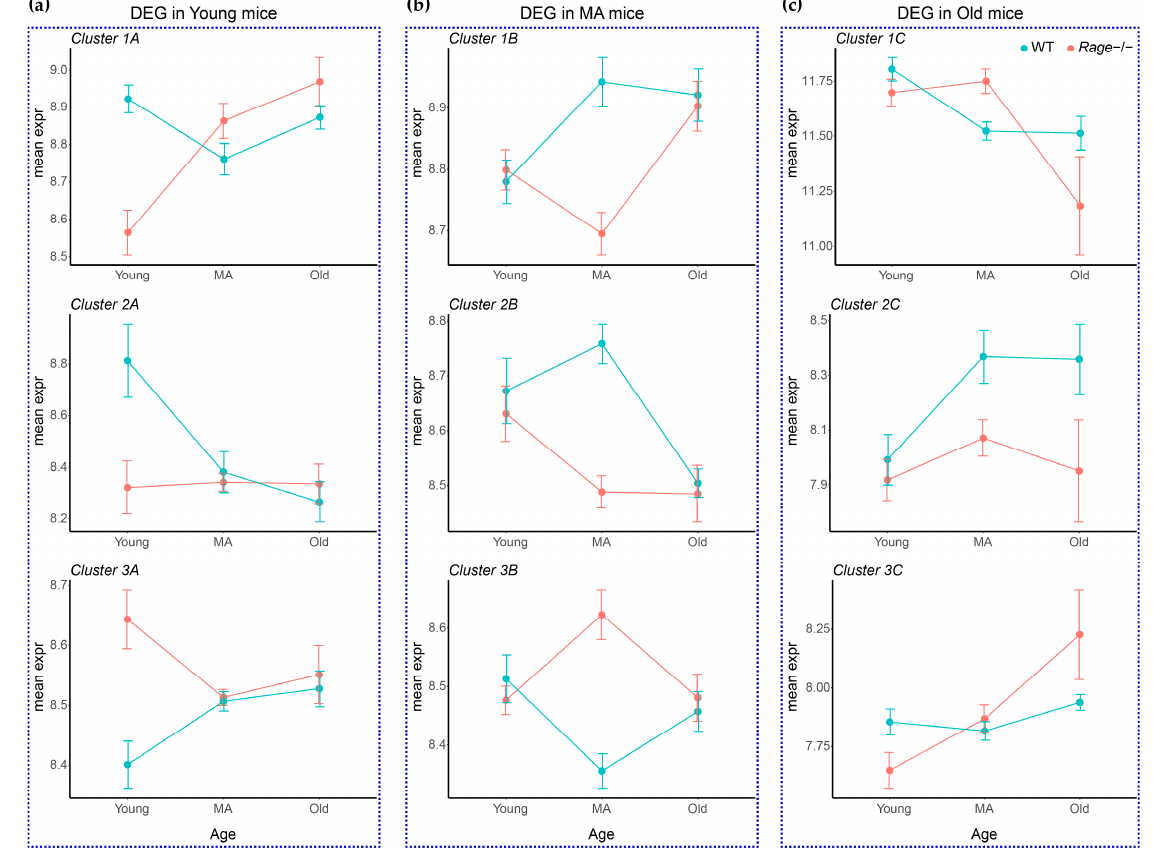
Figure 4. Time ‐ series. The average expression values of the genes constituting each cluster obtained by hierarchical clustering (cf. panels ( a ) through ( c ) in Figure 3) were used to draw line plots show ‐ ing the expression trend of these gene clusters. Panel ( a ) on the left represents the average expression of gene clusters 1A, 2A, and 3A in Rage − / − vs. WT Young mice. Panel ( b ) in the center depicts the average expression of gene clusters 1B, 2B, and 3B in Rage − / − vs. WT MA mice, and panel ( c ) on the right the 1C, 2C, and 3C clusters in Old mice. Pink and light blue lines and dots refer to Rage − / − and WT mice, respectively. Bars represent the standard deviation of the mean expression values between mice of the same age group. WT = Wild Type; MA = Middle Age. Young WT n = 5, Young Rage − / − n = 5, MA WT n = 4, MA Rage − / − n = 4, Old WT n = 5, Old Rage − / − n = 6.